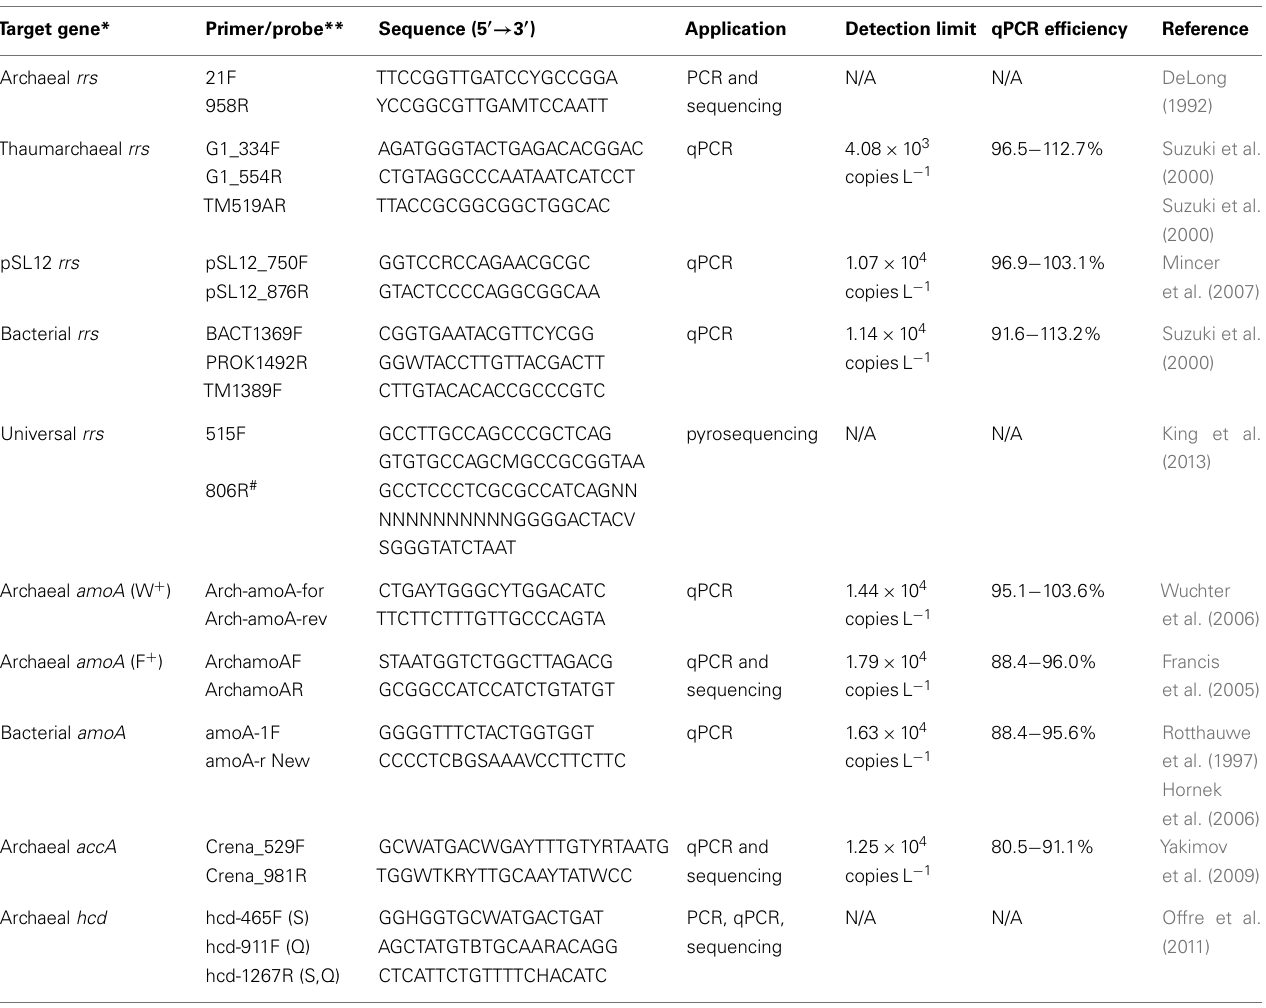
TableA1 | Primers used in this